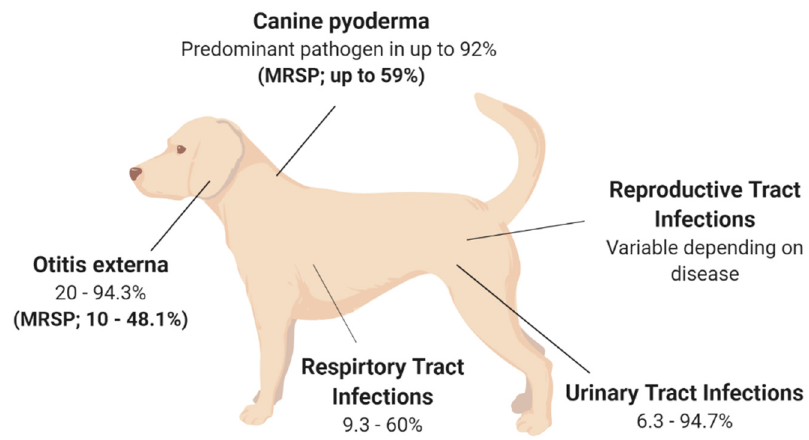
Figure 1. Isolation rates of S. pseudintermedius and MRSP from various disease states in canines. The isolation rates are presented as a range due to the variation described between studies; variation is described in detail in the main text. Canine pyoderma [22–25,29]; Otitis externa [2,32,34,36,38–43].;